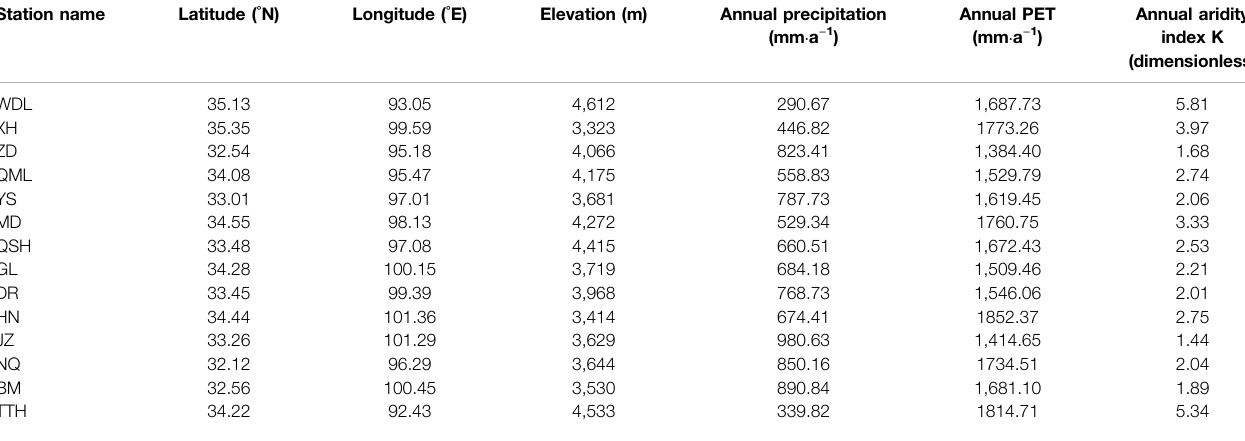
TABLE 2 | Annual precipitation, PET and aridity index K from GLDAS output in each weather